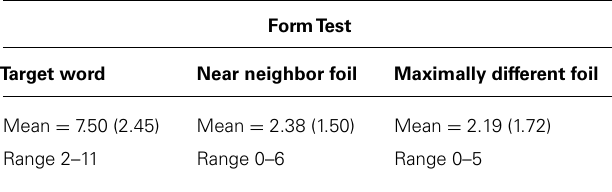
Table 1 | Means, standard deviations (in parentheses), and range of children’s response to each option in the form